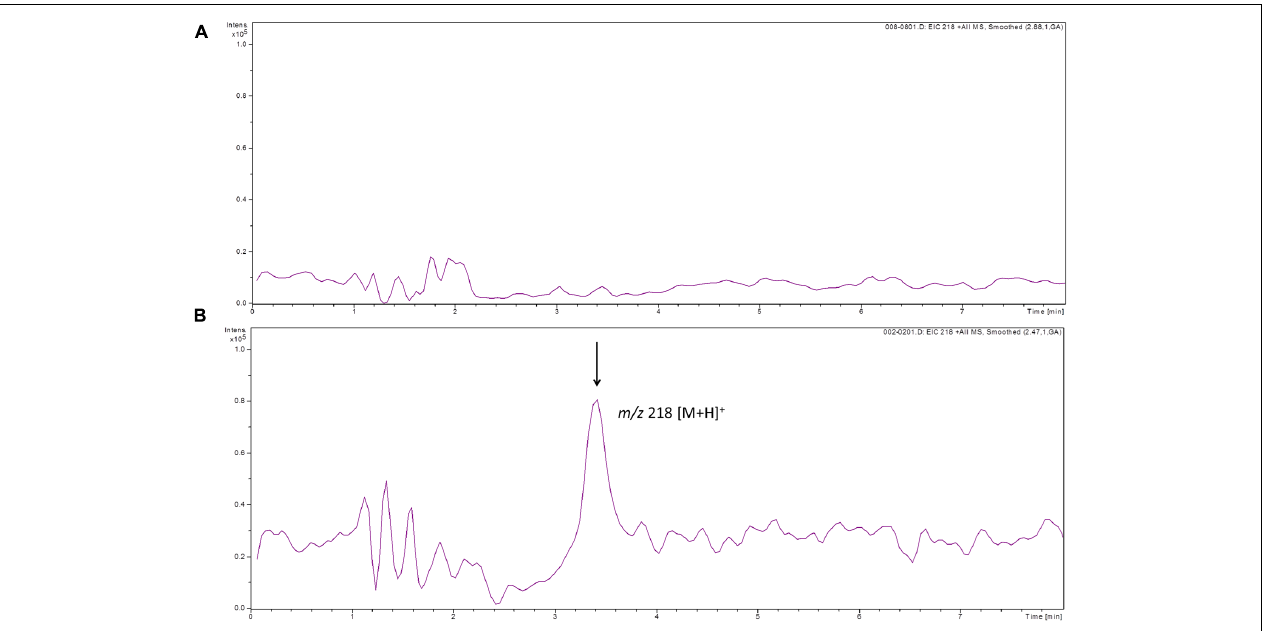
FIGURE 11 | HPLC/ESI-MS analysis of the glutamylated product generated by GlnA3 in in vitro assay. Two samples were analyzed in the MS positive mode: reaction mixtures without addition of GlnA3 (A) and with addition of GlnA3 (B) . Extracted ion chromatograms for the GlnA3 reaction product corresponding to gamma-glutamylputrescine with charge to mass ratio of 218 m/z was shown (B) , and no product in the sample without addition of GlnA3 could be detected (A)